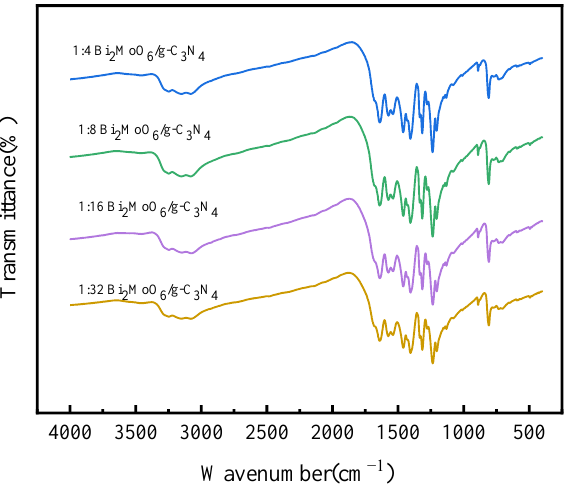
Figure 3. FT-IR spectra of Bi 2 MoO 6 /g-C 3 N 4 with different ratios between Bi 2 MoO 6 and g-C 3 N 4 pre- pared in this paper.